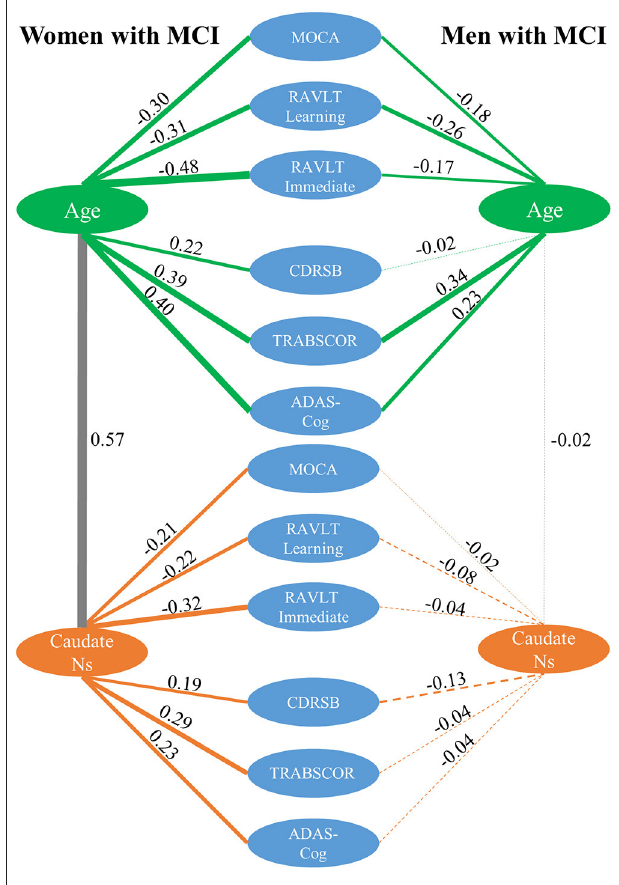
FIGURE 5 | Correlation analysis among caudate nodal strength (Ns), neuropsychological scores, and age for women and men with MCI separately. For simplicity, only left caudate nodal strength was presented in the figure. Green, gray, and orange lines represent the correlation between age and neuropsychological scores, between age and caudate nodal strength, and between caudate nodal strength and neuropsychological scores, respectively. Pearson’s correlations are marked in the figure with line thickness proportional to the correlation strength. A solid line means the correlation is significant ( p < 0.05) and dashed line means the correlation is not significant ( p >